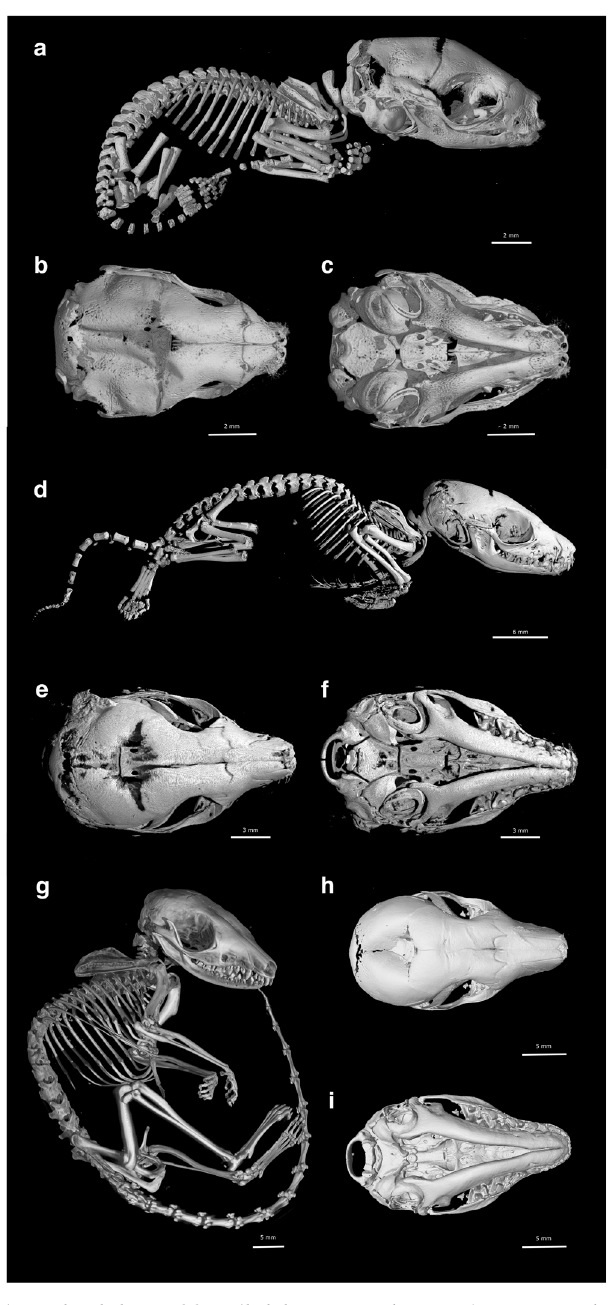
Fig. 7 The skeleton of fat-tailed dunnart pouch young (D35, D50 and D70), as revealed in microCT scans. The right lateral side of the skeleton is shown in ( a ), ( d ) and ( g ), the dorsal view of the skull in ( b ), ( e ) and ( h ), and the ventral view of the skull in ( c ), ( f ) and ( i ). Pouch young on D35 are shown in ( a ), ( b ) and ( c ). Pouch young on D50 are shown in ( d ), ( e ) and ( f ). Pouch young on D70 are shown in ( g ), ( h ) and ( i